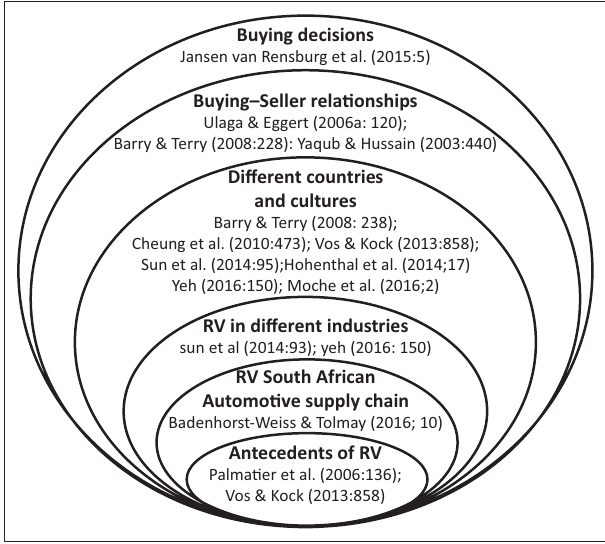
FIGURE 1: Relationship value research opportunities identified from the